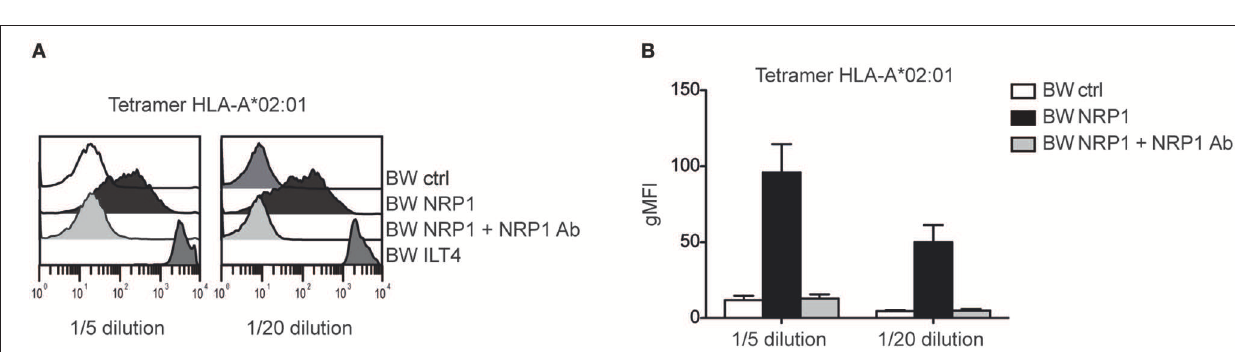
FIGURE 6 | NRP1 interacts with MHC class I molecules . (A) Binding of tetramers representing MHC class I molecule HLA-A*02:01 (CMV CLGGLLTMV) with BW control cells and BW cells expressing NRP1 or ILT4 in the presence or absence of a polyclonal NRP1 antibody via flow cytometry. (B) Data of two independently performed binding experiments is shown. gMFI, geometric mean of fluorescence